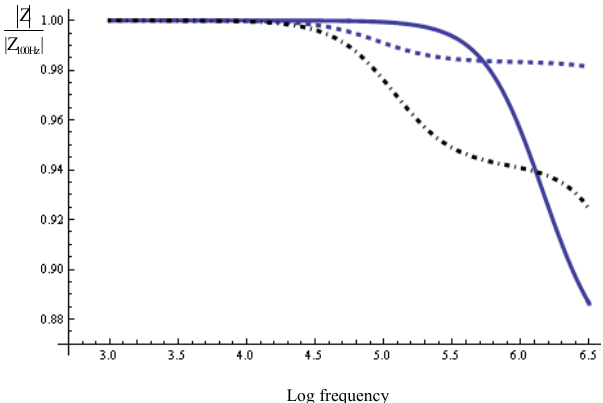
Fig. 3.B: Spectra of Impedance magnitude relative to the value at 100 Hz for suspensions of charged liposomes σ 3 = 0.377 S/m & D 3 = 5 ×10 -9 m 2 /s (solid); σ 3 = 0.377 S/m & D 3 = 5×10 -10 m 2 /s (dashed); σ 3 = 0.1 S/m & D 3 = 5×10 -10 m 2 /s (dot-dashed)